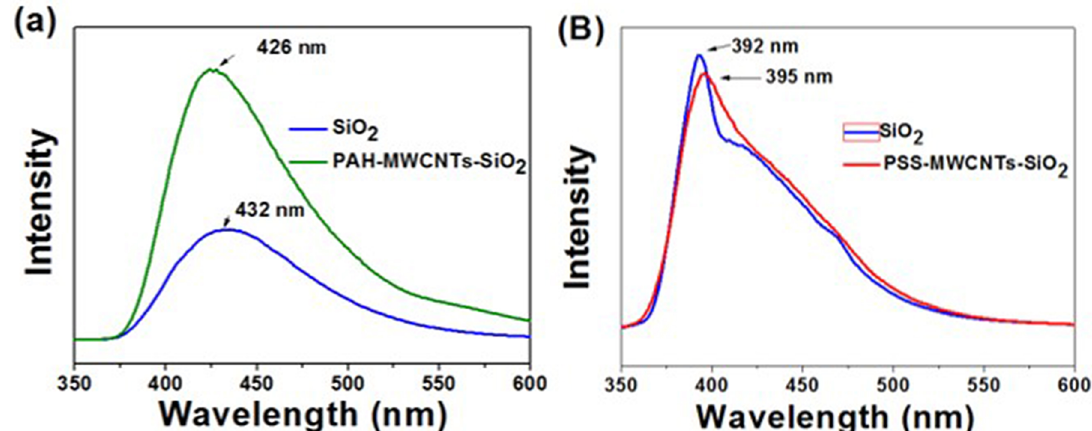
and (b) silica nanoparticles and PSS-MWCNTs- 2